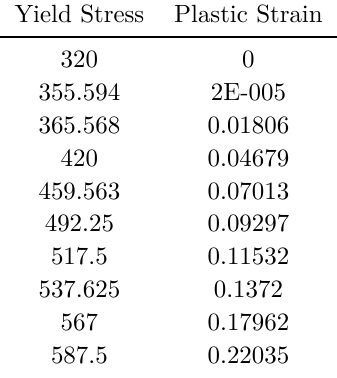
Material behavior assigned in Abaqus (Plastic